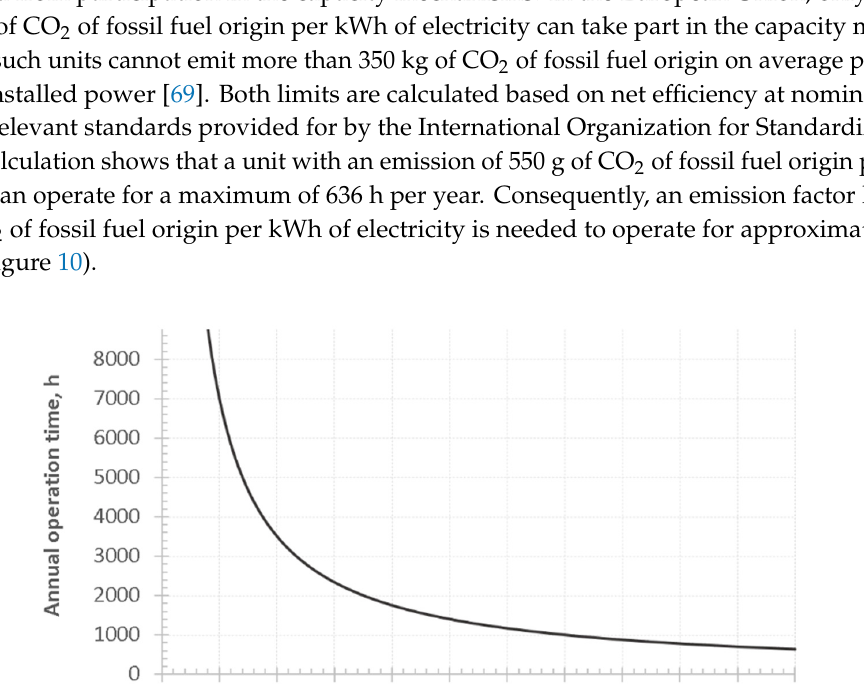
Figure 9. Results of NPV analysis for different prices of 1 kW/year on the capacity market (for technical minimum amounting to 30% of the rated power, Y = 1, r = 9%).